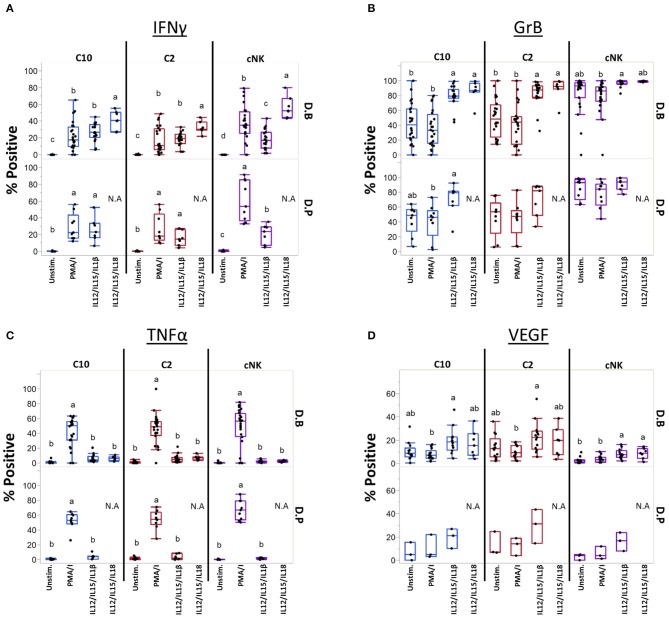
Unique ILCs respond to cytokine stimulation. C10, C2, and cNKs were stimulated with PMA/Ionomycin, IL-12/IL-15/IL-1β, or IL-12/IL-15/IL-18 and production of (A) INFγ, (B) Granzyme B, (C) TNFα, and (D) VEGF was assessed. Data represented as max/min, median, and 25 and 75th percentiles. Statistical significance was determined by ANOVA followed by Tukey test and are demonstrated by letters, with different letters indicating statistical differences within a subset (<0.05). Additionally, comparisons across subsets within tissues were performed, for simplicity p-values are found in Supplementary Table 10. For (A–C, unstim and PMA/Ionomycin): Decidua basalis, n = 24; decidua parietalis, n = 9. For (A–C, IL12/IL15/IL1β): Decidua basalis, n = 19; decidua parietalis, n = 7 (A–C, IL12/IL15/IL18): Decidua basalis, n = 7. For (D, unstim, PMA/Ionomycin, IL12/IL15/IL1β): Decidua basalis, n = 13; decidua parietalis, n = 3. For (D, IL12/IL15/IL18): Decidua basalis, n = 7. N.A = not analyzed. For statistical details see Supplementary Table 10. Data is provided in Data Sheet 1.